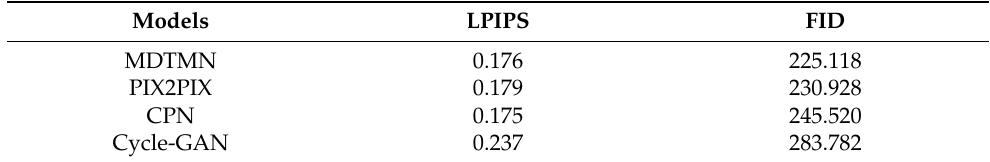
Table 3. The comparison results between the autonomous generation of pavement distress images by each algorithm and the real